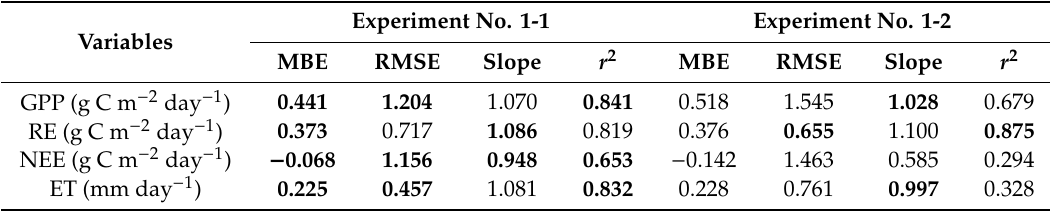
Table 4. Statistical parameters for error assessment of Experiments 1-1 and 1-2. MBE and RMSE indicate mean bias error and root-mean-square error, respectively. Slope and r 2 were obtained from linear regression analysis 1 . GPP, RE, NEE, and ET represent the daily gross primary production, ecosystem respiration, net ecosystem exchange, and evapotranspiration, respectively. Numbers in bold indicate the best estimations based on each of the statistical parameters for error assessment.